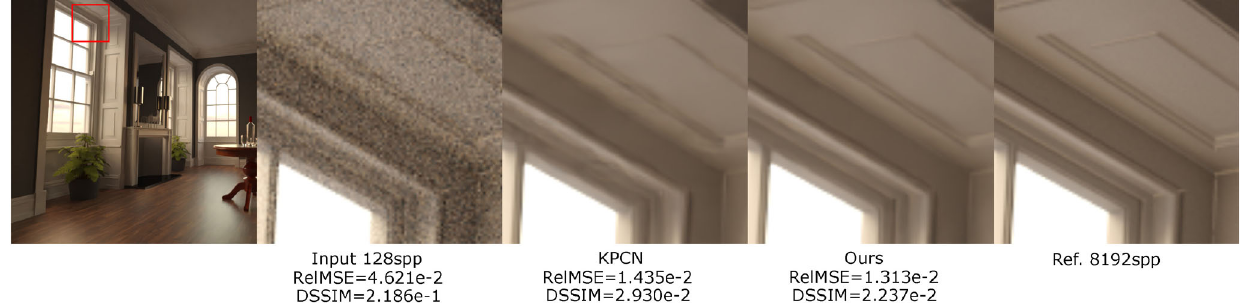
Fig. 1 Comparison of output of our network and the Kernel Predicting Convolutional Network (KPCN) using the same dataset for training. Our model preserves details better, due to the novel network structure, a new feature (light transport covariance in path space), and the perceptual loss function. Quantitative error metrics (RelMSE and DSSIM) also confirm the higher quality of our